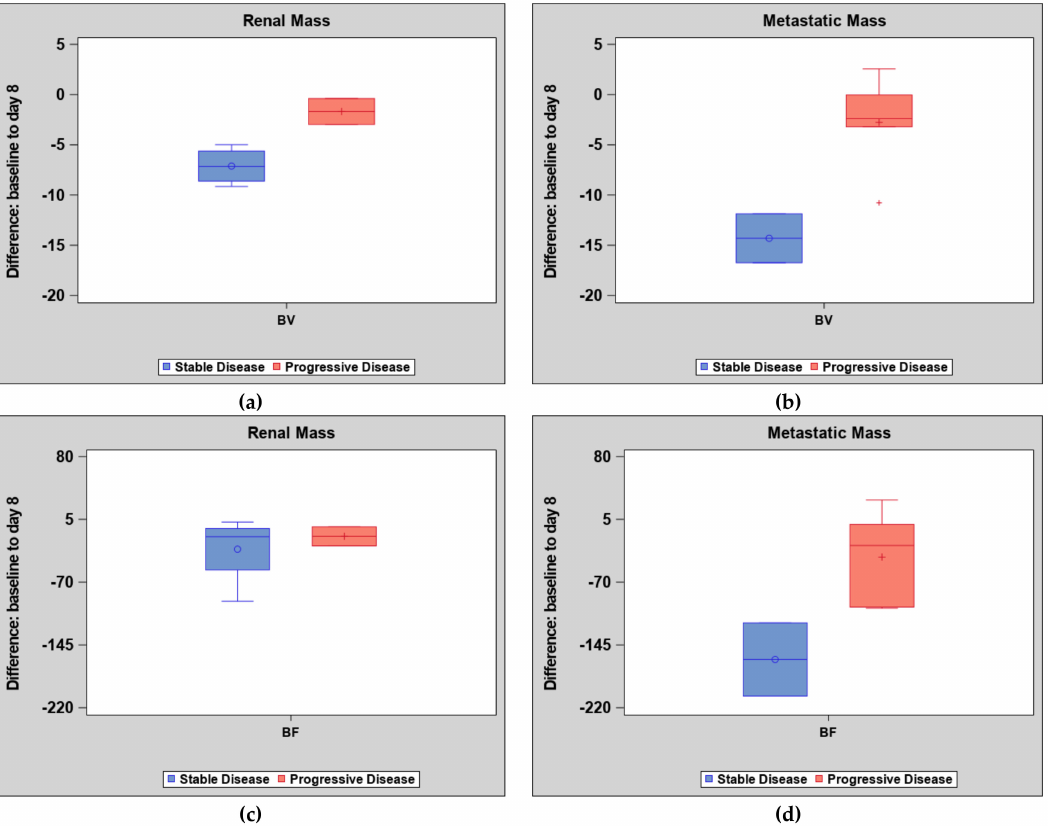
Figure 4. Blood volume and blood flow changes by clinical response and tumor location. ( a ) Di ff erences in blood volume (BV) in primary renal lesions on day eight of treatment with tyrosine kinase inhibitor in patients who had either stable or progressive disease by RECIST 1.1 criteria at 12 weeks post-treatment. ( b ) Di ff erences in blood volume (BV) in metastatic renal cell carcinoma lesions. ( c ) Di ff erences in blood flow (BF) in primary renal lesions on day eight of treatment. ( d ) Di ff erences in blood flow (BF) in metastatic lesions. Note that stable disease shows a larger decrease in BV in both primary kidney masses and metastatic disease compared to progressive disease and a greater decrease in BF is seen in stable metastatic disease compared to progressive